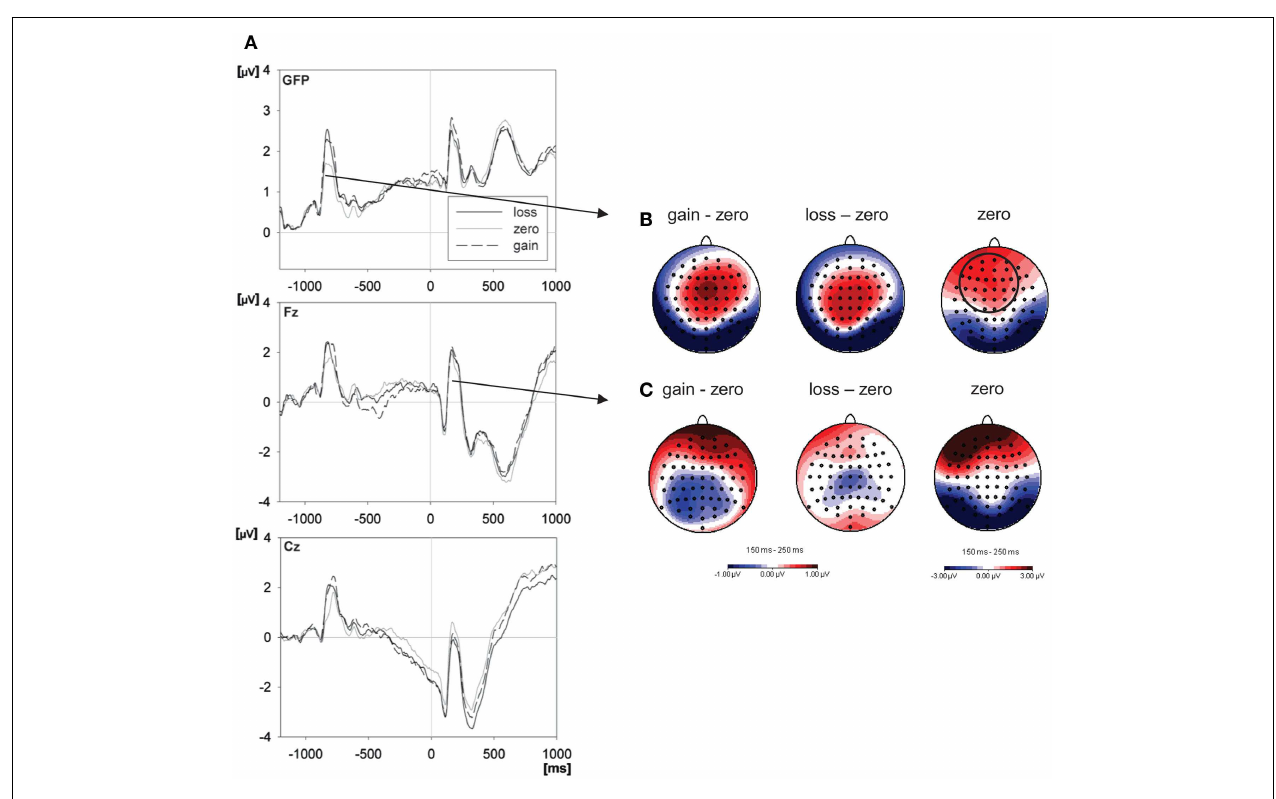
distributions (standard amplitude subtraction) of the differences between expected gain and zero outcome condition and between expected loss and zero outcome condition and, further, the distribution of ERPs in the zero outcome condition within the 150–250-ms interval after the cue (B) and after the word (C) (electrodes of the P2 peak analysis are indicated by the